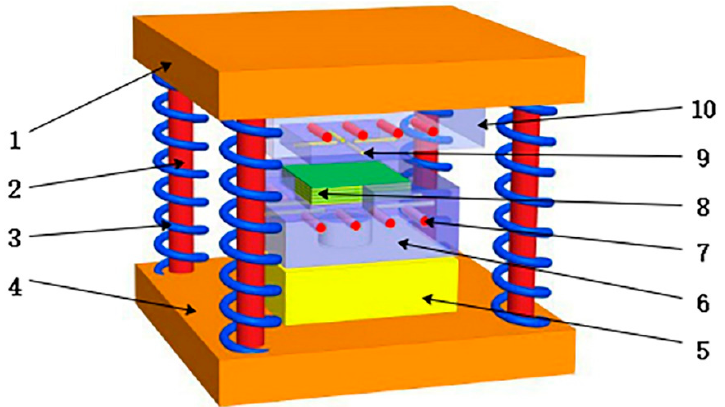
Figure 4. Assembly structure diagram of concave–convex die. 1—convex die fixing plate; 2—pillar; 3—spring; 4—concave die fixing plate; 5—concave die pad; 6—concave die; 7—heating resistor hole; 8—composite material; 9—thermocouple hole; 10—convex